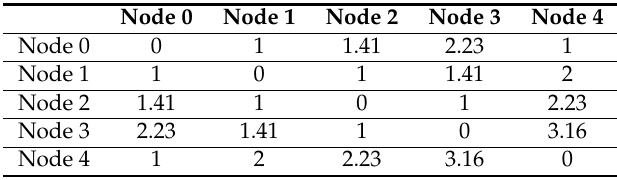
Table 6. The cost matrix for the network G 2 .